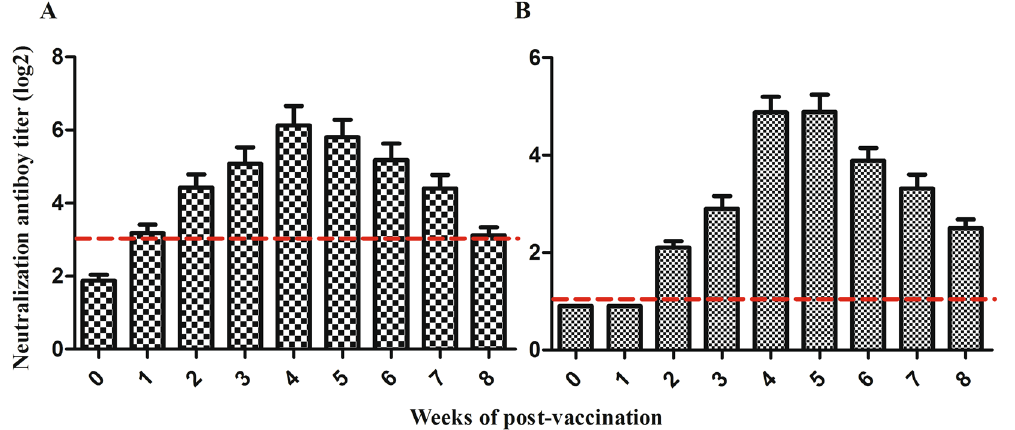
Figure 4. C-KCE-HA/PrM-E viruses prime humoral responses. Ducks were vaccinated with PBS, 10 5 PFU of C-KCE or C-KCE-HA/PrM-E (n = 10 per group) subcutaneously. Sera were obtained at the indicated time points to detect the neutralization antibodies against XN/07 and df2. ( A ) XN/07-neutralizing antibodies were measured by neutralization assay on MDCK cells. ( B ) df2-neutralizing antibodies were determined by neutralization assay on BHK-21 cells. The dashed line shows the detection limit for a positive